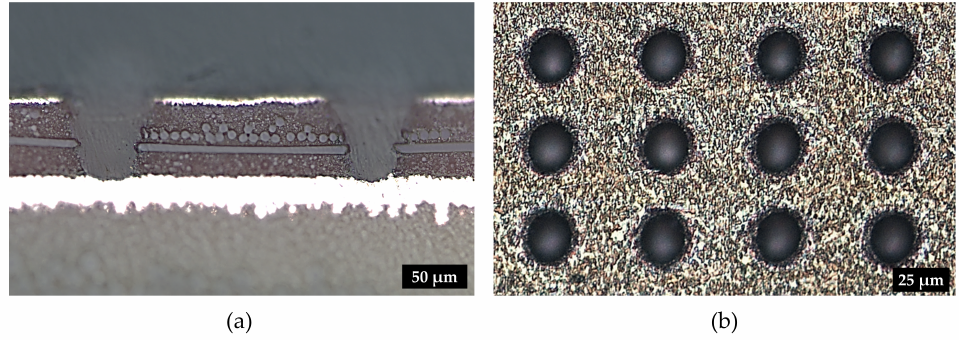
Figure 3. Evaluation of the microvia quality after laser percussion drilling process using ( a ) materi- alography and ( b ) optical